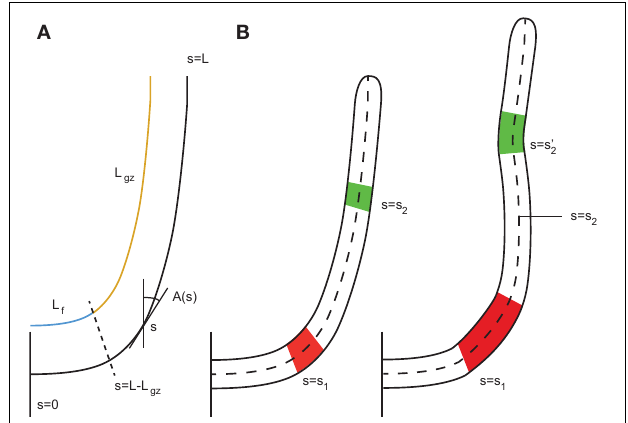
FIGURE 1 | Geometric description of a rod-like plant organ. (A) The arc length s is defined along the median line of the organ with s = 0 referring to the base and s = L the apex. The total length of the organ L can be broken down into the length of the growth zone L gz , which is moving with the apex, and L f , the length of the zone which is not growing. This fixed portion elongates with time as elements leave the active growth zone. A ( s ) is the local orientation with respect to the vertical. (B) To simplify this, only two parts of the organ are considered to be elongating, the red part, at a position defined at its base s = s 1 , and the green part, at a position defined at its base s = s 2 . During elongation, the curvatures of these two parts are modified. Due to elongation, their distance relative to each other is modified. The position s = s 2 no longer refers to the green element. To account for the variation in the material element, the derivative must follow the material